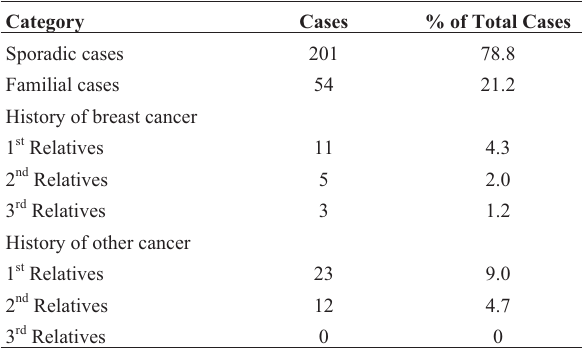
Table 3 - Breast cancer patients with family history of